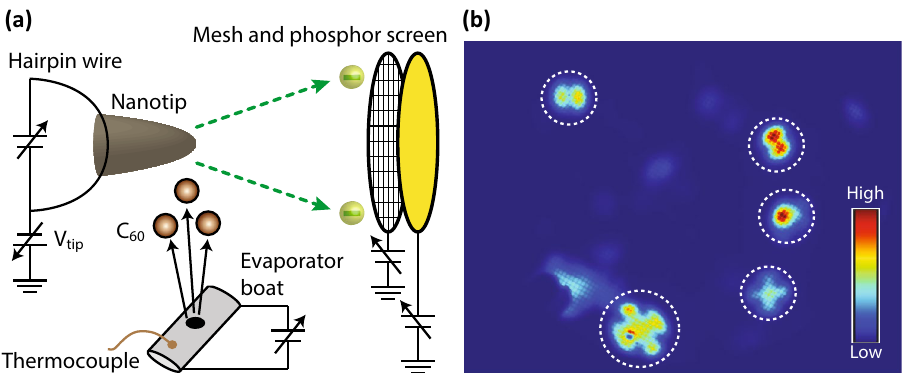
Figure 1. Experimental setup and typical FEM images of molecules. ( a ) Schematic diagram of our experimental setup of a field emission microscope. See the Method section for details. ( b ) Field emission patterns from single molecules. The patterns surrounded by dashed circles represent the molecule